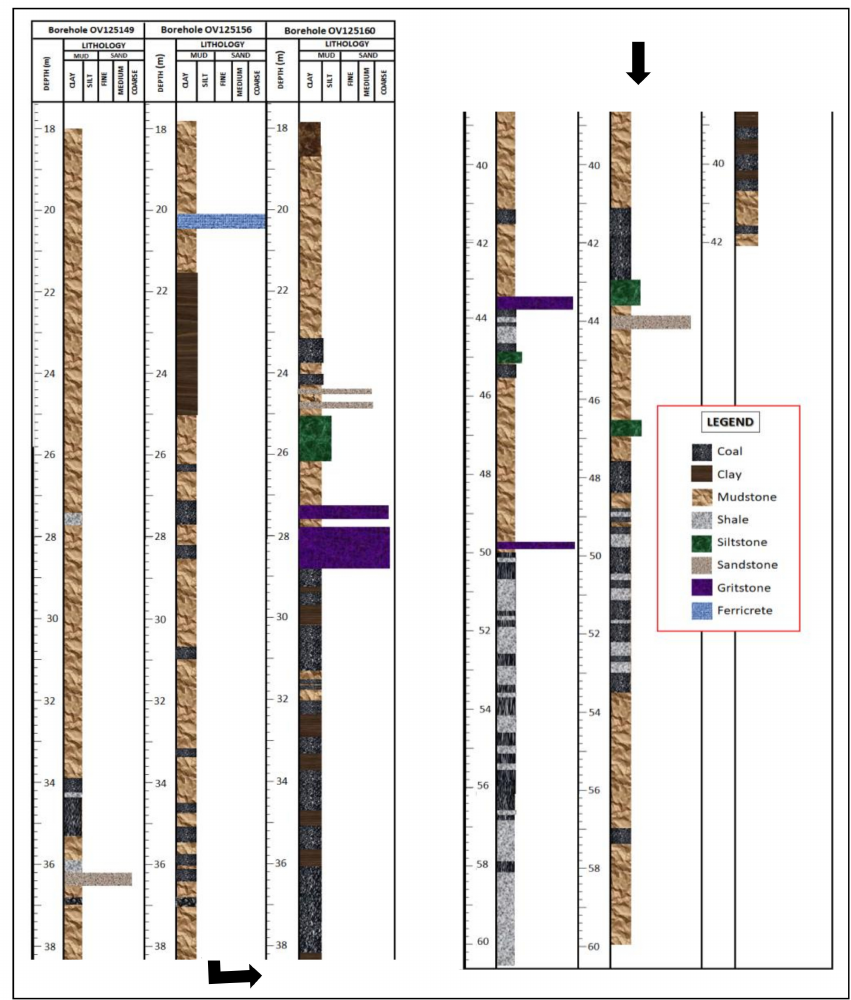
Figure 4. Stratigraphy of the Madzaringwe Formation in boreholes OV125149, OV125156 and OV125160. Note: No core recovery from the surface down to a depth of 18